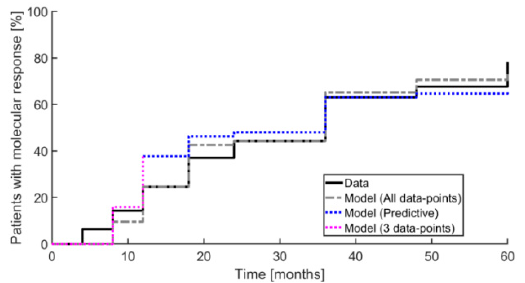
Figure 4. An inverse Kaplan–Meier plot is shown illustrating the fraction of patients obtaining a partial molecular response (50% reduction relative to baseline) during the 60 months of measurement. The full black curve shows data and the grey dashed curve shows model prediction using all data points for calibration. The dotted blue curve shows the model prediction, where for each step only the preceding data points were used. The dashed purple curve shows the predictions of the first three data points using these for calibration.